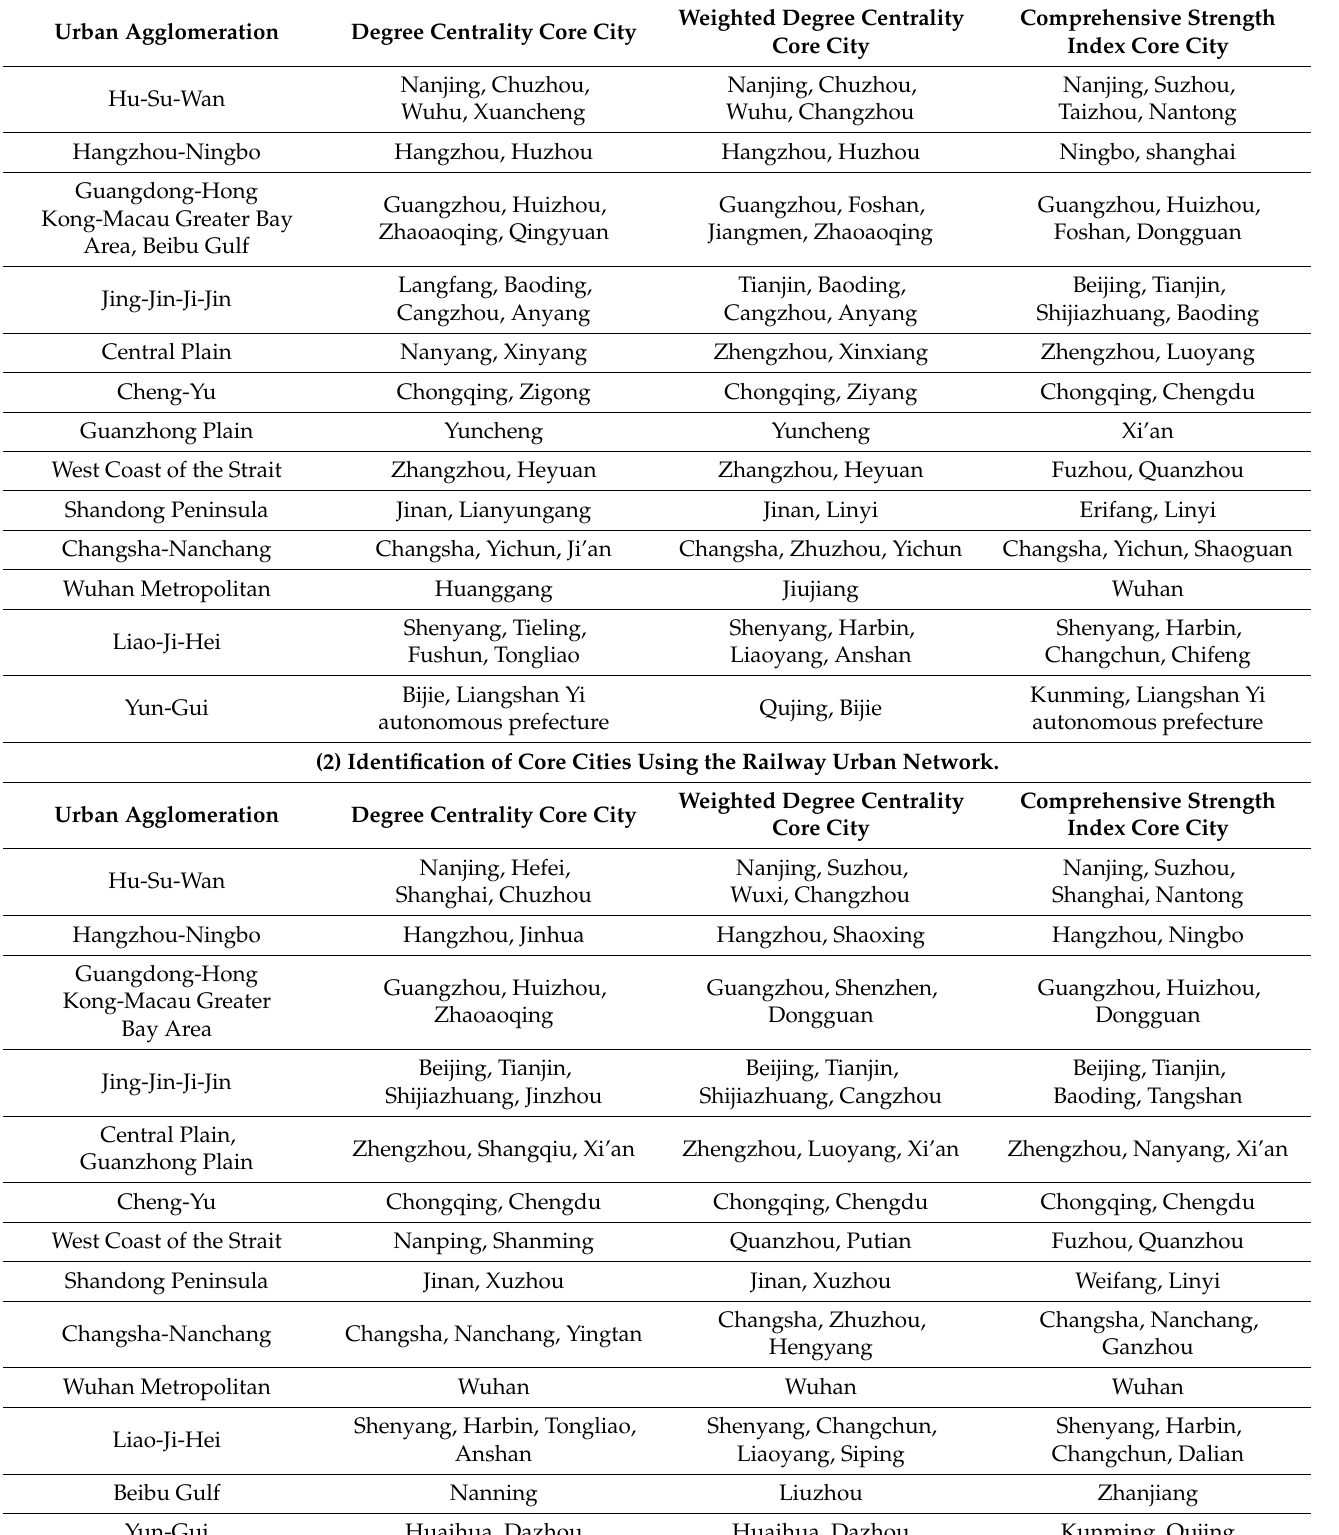
Table 4. Statistics of core city identification results. (1) Identification of Core Cities Using the Nighttime Light Urban